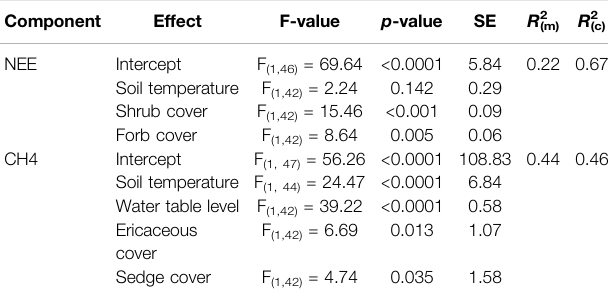
TABLE 6 | Statistical results of multiple linear regressions to predict NEE and CH 4 fl uxes in 2017 and 2018, based on soil temperature (at 5 cm depth), cover of vegetation strata, and water table level. Marginal R 2 (m) shows the proportion of variance explained by the fi xed factors alone, while the conditional R 2 (c) describes the proportion of variance explained by fi xed factors and the random factor “ plot ”